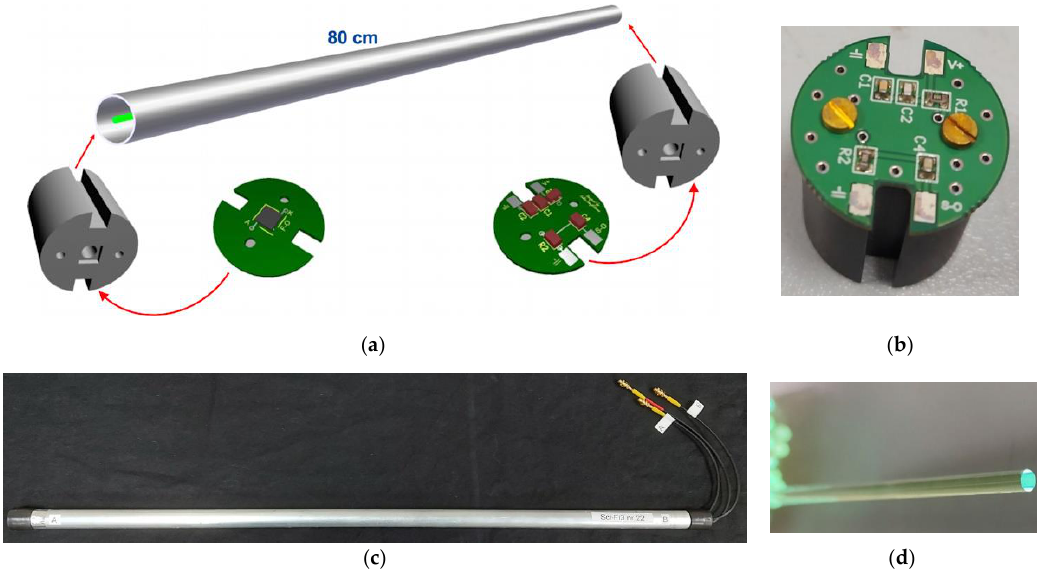
Figure 8. ( a ) Sketch of the components of the SciFi detector assembly. ( b ) A fiber holder with the SiPM PCB in place. ( c ) A detector fully assembled. ( d ) A 3 mm diameter fiber.